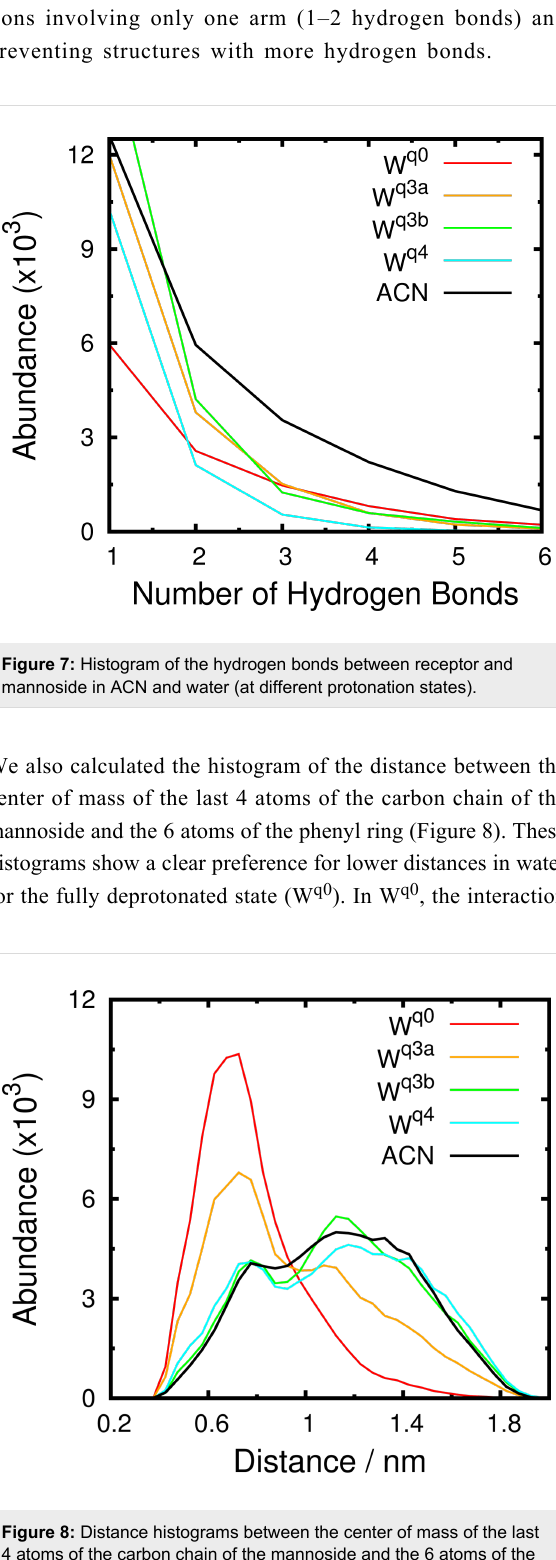
Figure 8: Distance histograms between the center of mass of the last 4 atoms of the carbon chain of the mannoside and the 6 atoms of the phenyl ring in the receptor. Calculations were done in ACN and water (at different protonation states).